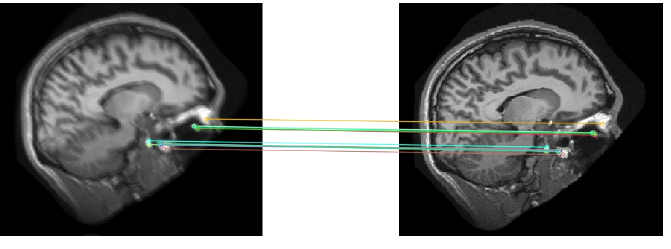
Figure 3. Alignment of Input and Target Images Using Matching Landmarks. ( Left ): image with synthetic blur after applying a random kernel. ( Right ): target